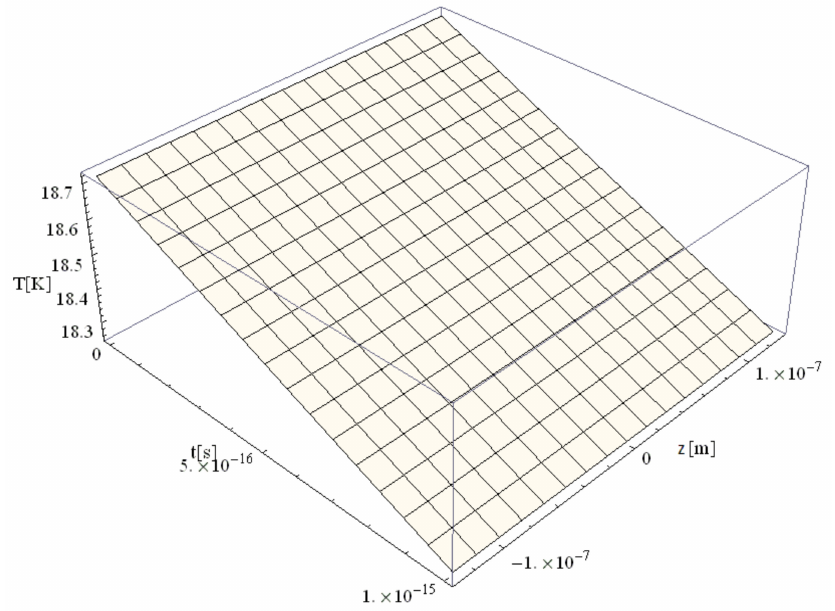
Figure 5. Electron temperature versus time and z during 1 fs simulation after irradiation with a 100 as laser pulse applied to an Au microparticle with a 130 nm